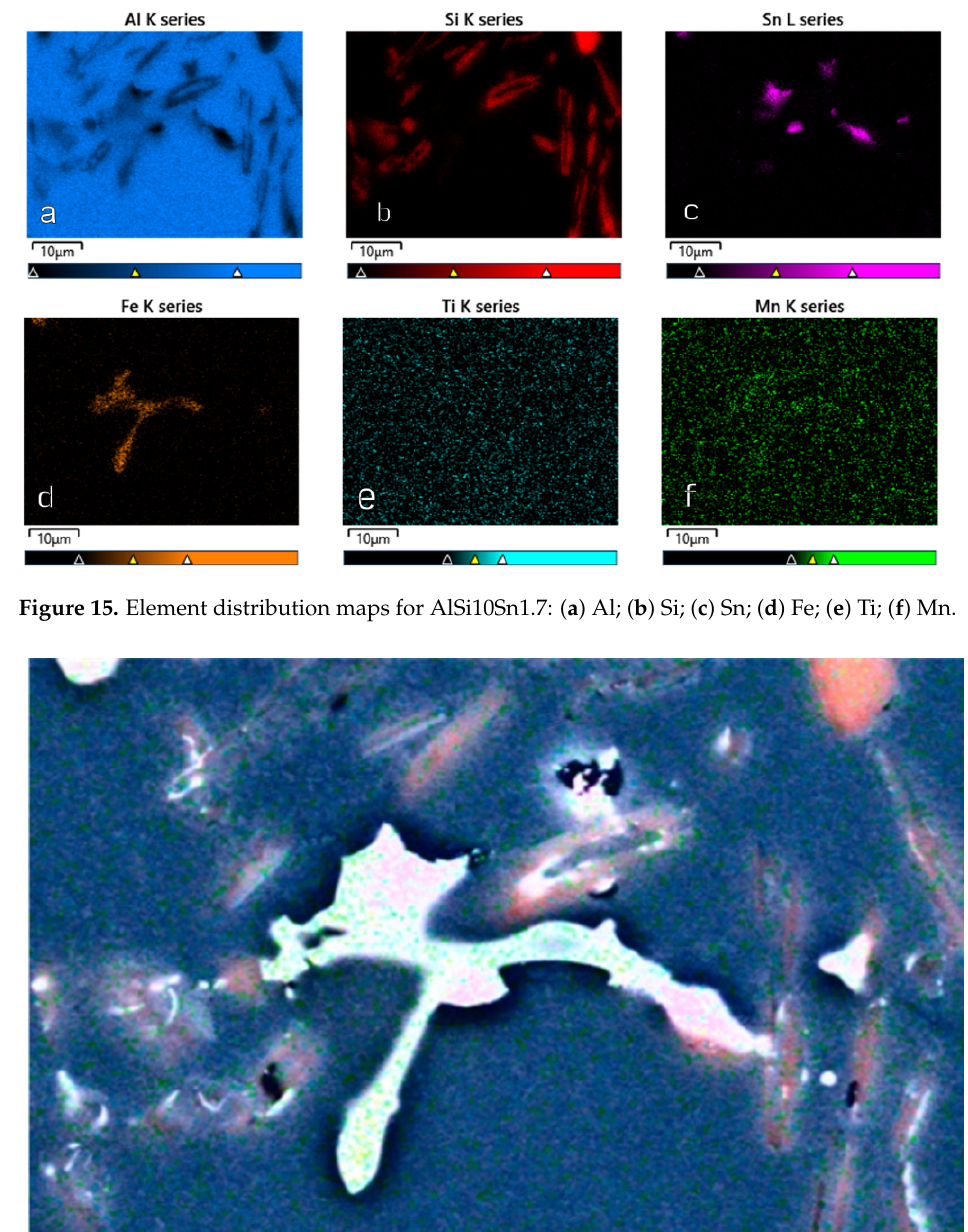
Figure 14. Microstructure of AlSi10Sn1.7 alloy with Sn addition (electron image).